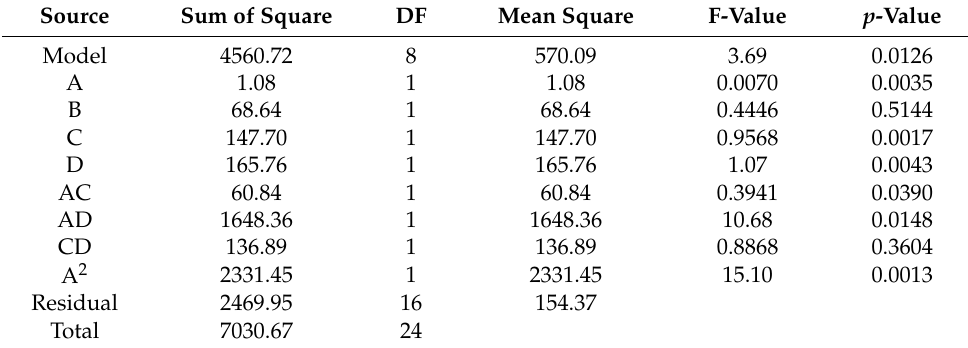
Table 4. The analysis of variance (ANOVA) results of the second-order